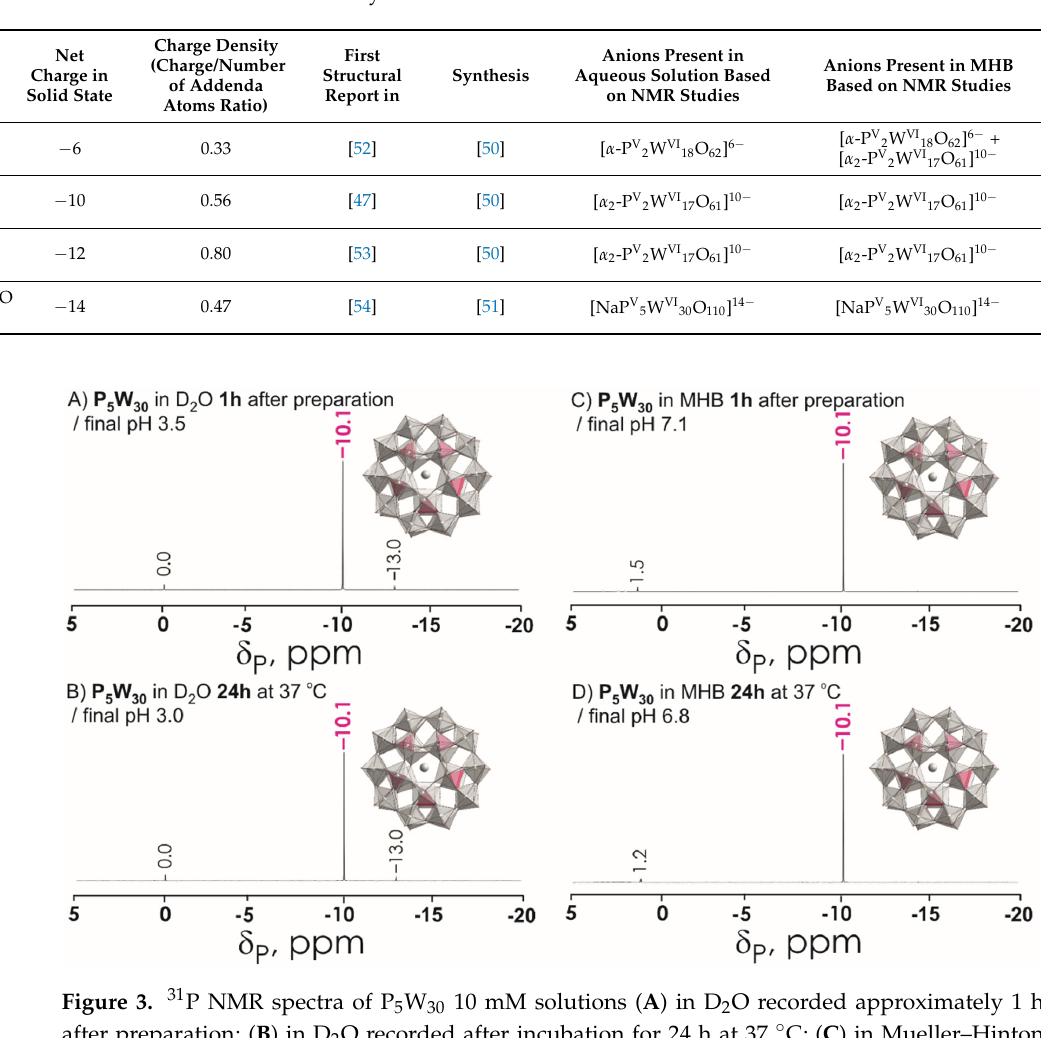
Table 2. POTs used in this study.